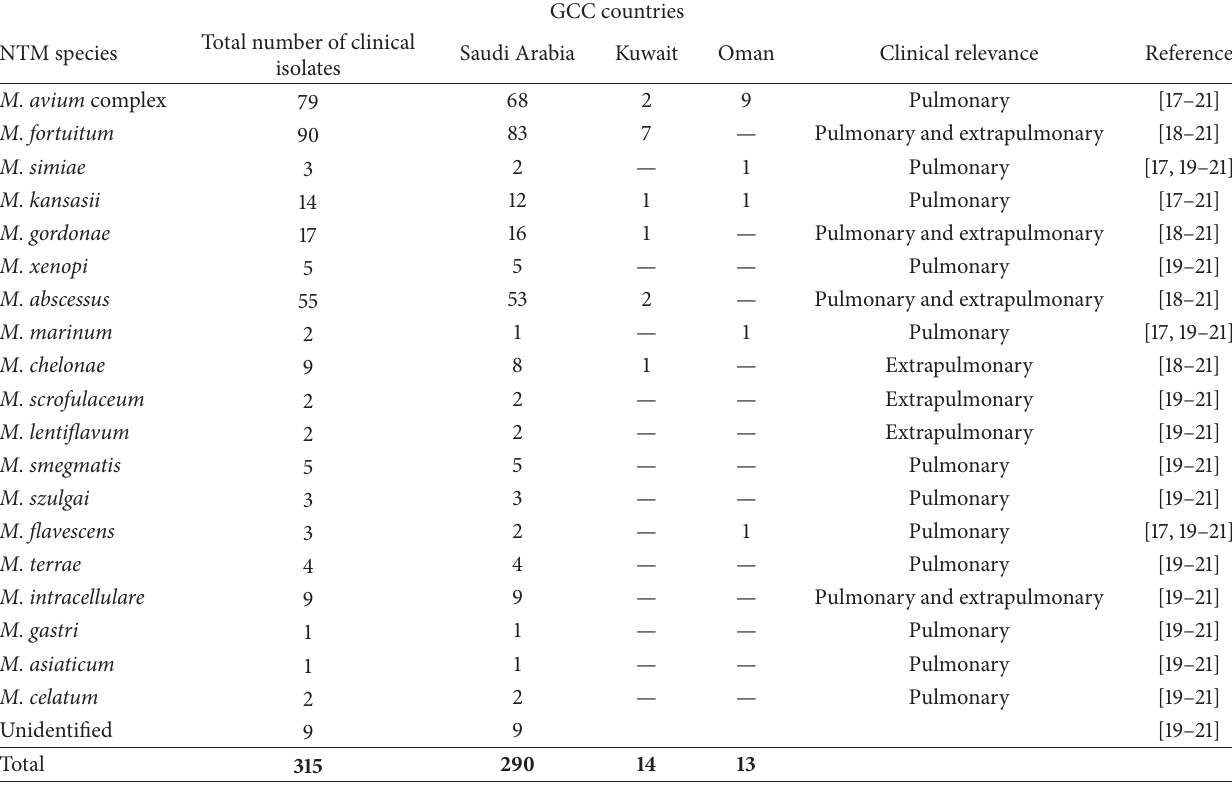
Table 1: Species distribution of NTM in the Gulf